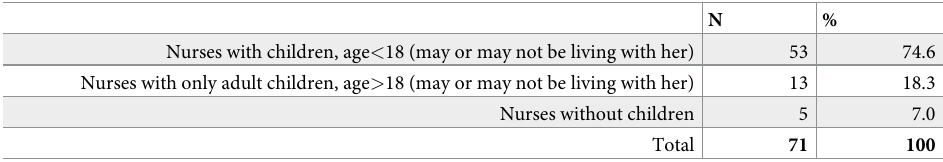
Table 3. Nurses and children. Nurses with children, age < 18 (may or may not be living with her) 53 74.6 Nurses with only adult children, age > 18 (may or may not be living with